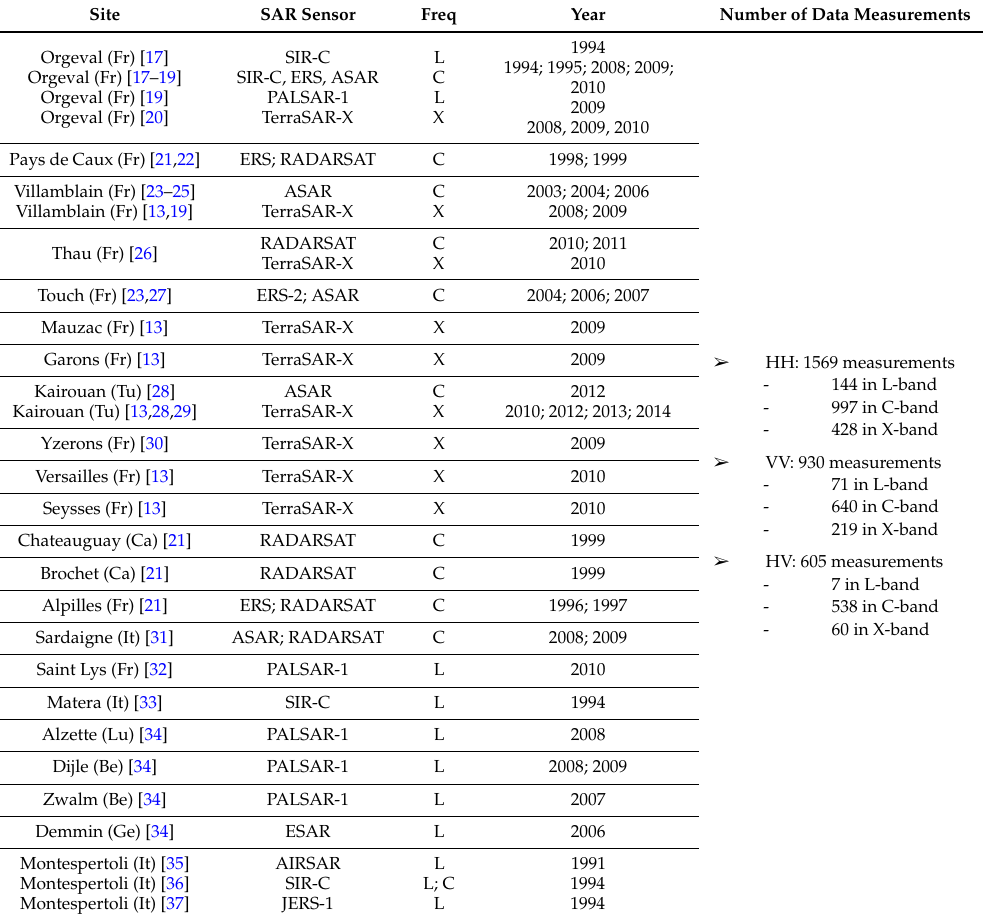
Table 1. Description of the dataset used in this study. “Fr”: France, “It”: Italy, “Ge”: Germany, “Be”: Belgium, “Lu”: Luxembourg, “Ca”: Canada, “Tu”: